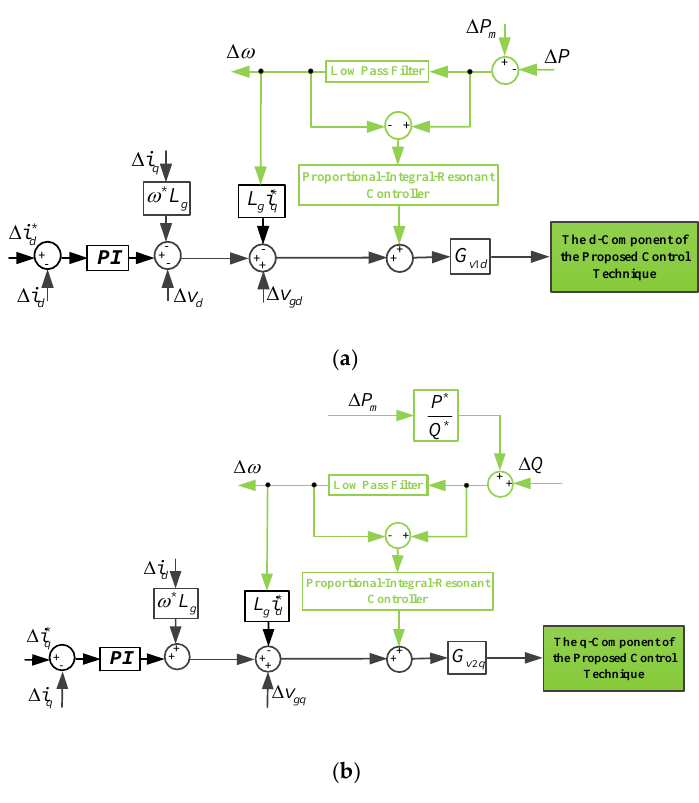
Figure 2. The proposed controller: ( a ) d -component; ( b ) q -component. Figure 2 . The proposed controller: ( a ) d -component; ( b ) q -component . Table 1. The parameters and power values considered in simulation